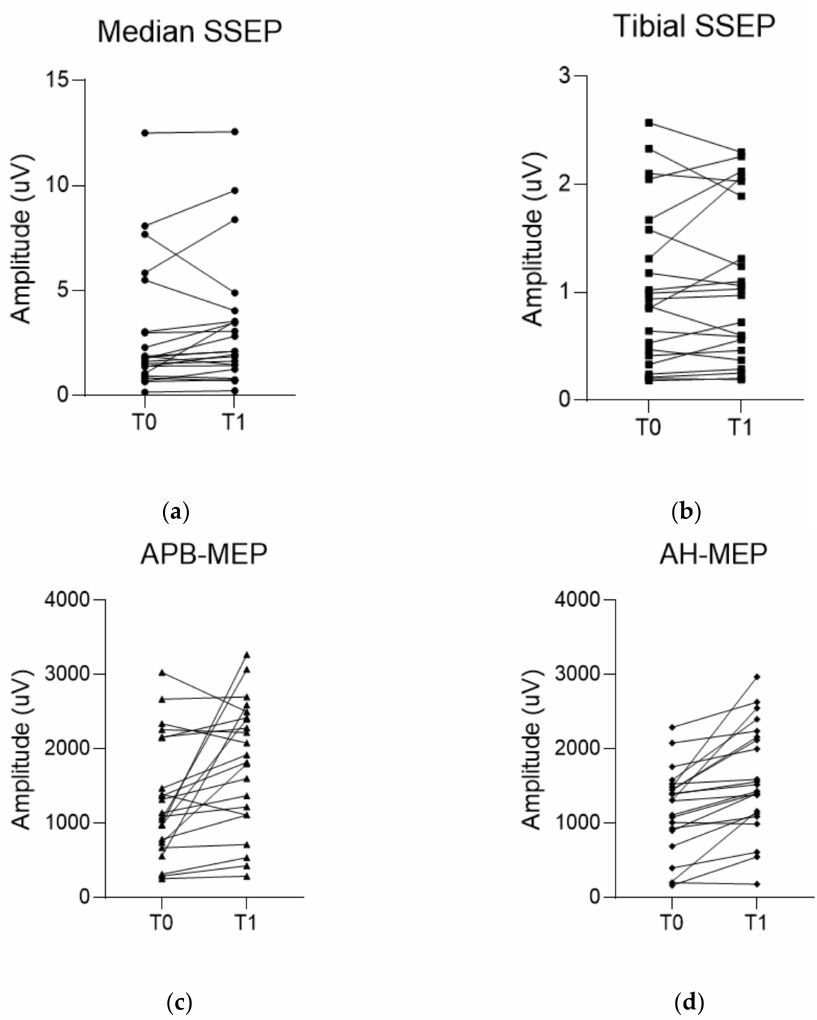
Figure 5. Changes in amplitude of each evoked potential (EP) during the surgery. ( a , b ) Median and tibial somatosensory evoked potential (SSEP) do not show a significant increase in amplitudes between baseline and final values. On the other hand, ( c , d ) motor evoked potentials recorded in the abductor pollicis muscle (APB-MEP) and abductor hallucis muscle (AH-MEP) show a significant increase in their amplitudes between baseline and final values. T0 indicates the baseline EP. T1 indicates the final